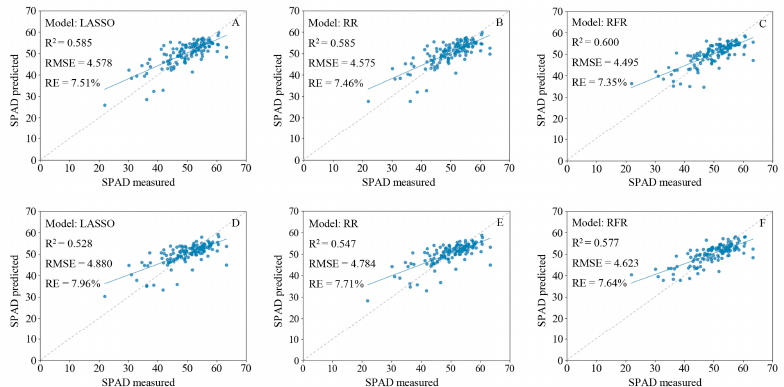
Figure 6. Fitting results of predicted and measured SPAD values of wheat leaves based on a full- band hyperspectral re fl ectance and fi rst derivative model. ( A – C ) Least absolute shrinkage and se- lection operator (LASSO) regression, ridge regression (RR), and random forest regression (RFR) models built with full-band hyperspectral re fl ectance; ( D – F ) LASSO regression, RR, and RFR mod- els built with full-band hyperspectral fi rst derivative. The gray do tt ed line is the 1:1 fi t between the predicted and measured SPAD values, and the blue solid line is the actual fi t between predicted and measured values.